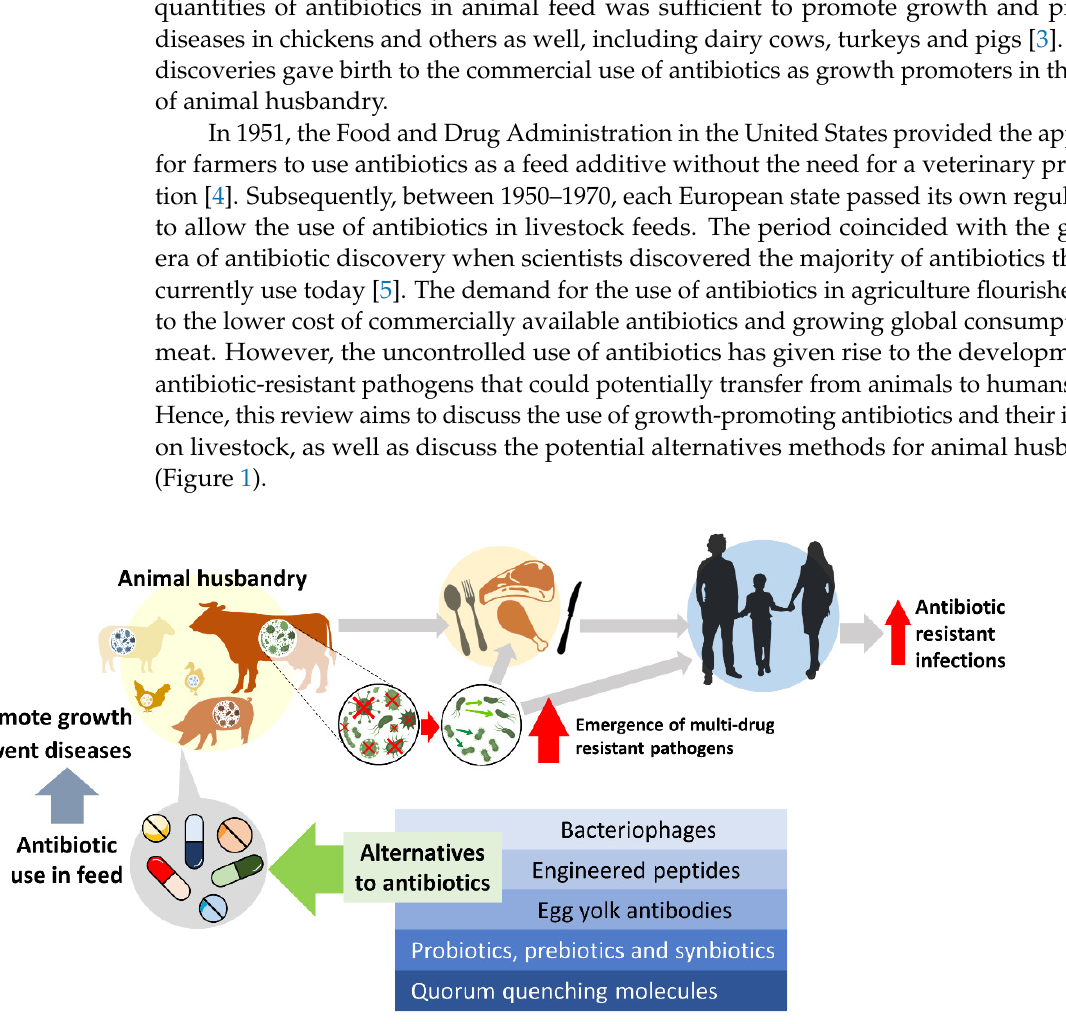
Figure 1. The effect of growth-promoting antibiotics usage in animal husbandry and the potential alternatives for livestock in disease prevention and growth promotion.